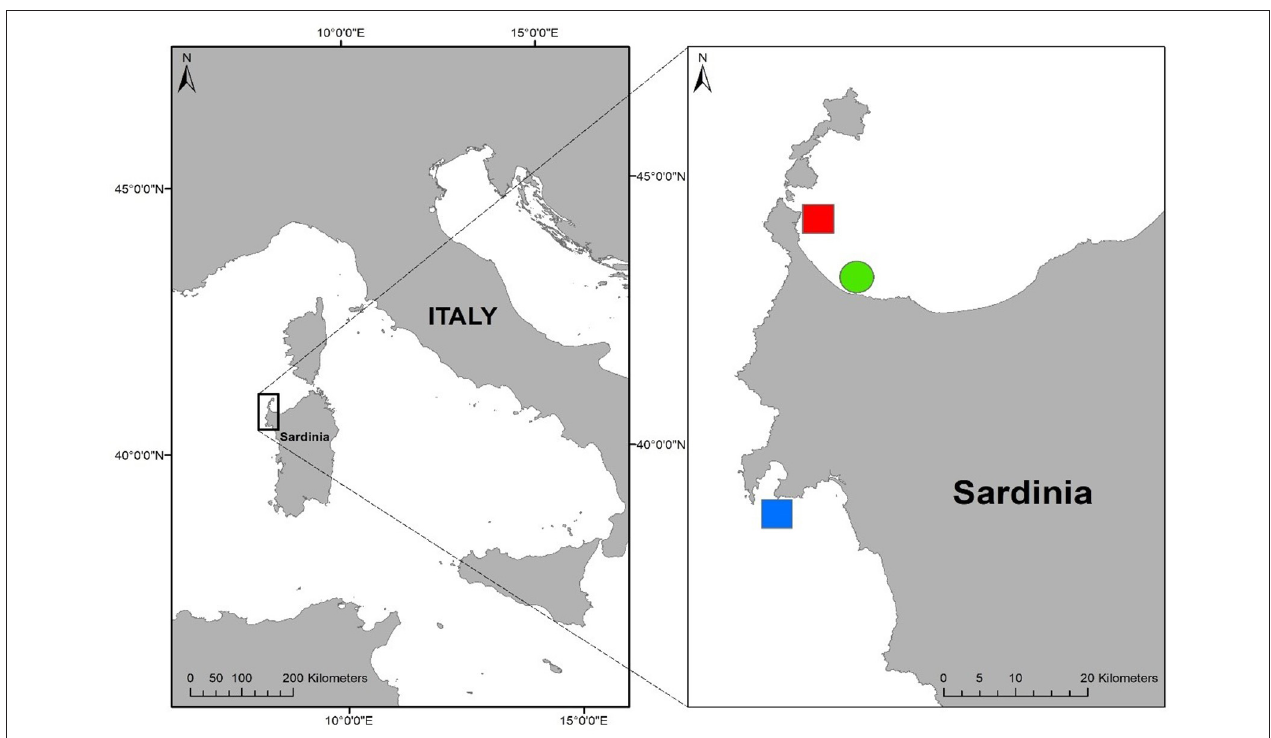
FIGURE 1 | Study area: North-West Sardinia (Italy). The red spot represents the warm site (Le Saline); the blue spot the cold site (Porto Conte) and the green spot the common garden (Fiume Santo).